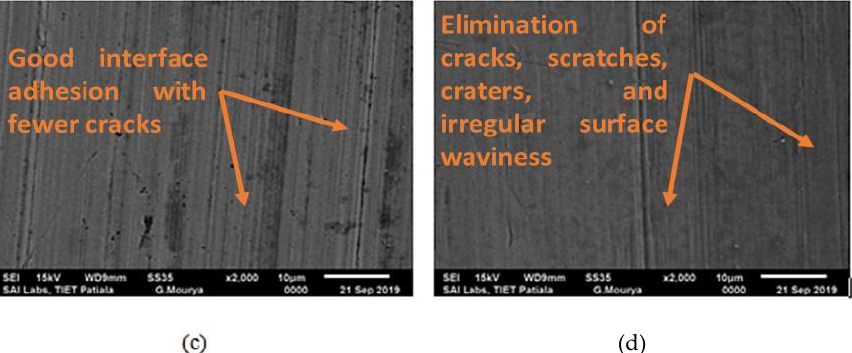
Figure 7. SEM image of Inconel 625 tube. ( a ) Rough surface; ( b ) chemically treated surface; ( c ) finished internal surface (PT-75, AS-60, SRS-180, CC-600, WPS-35%); ( d ) finished external surface (PT-75, AS-60, SRS-180, CC-600, WPS-35%).